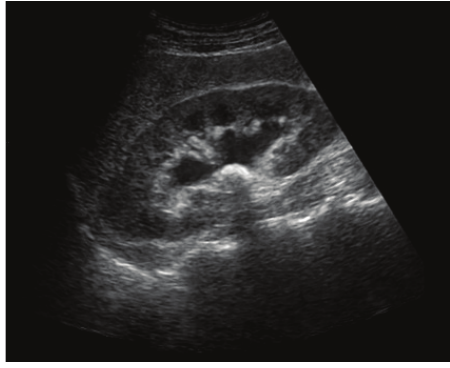
Figure 1 -Ultrasound image of a kidney of a patient with urolithiasis. In the structure of the tissue, pyramids and pelvis, inflammatory and degenerative changes are noticeable, as well as hyperechoic contents on the left: a rounded calculus, 10 × 5 mm in size